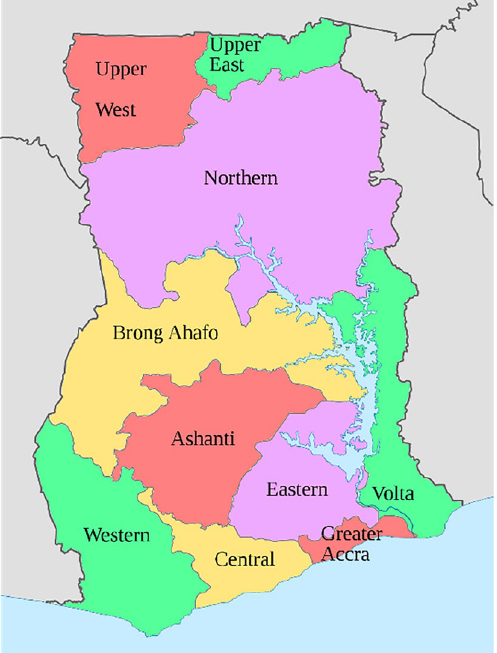
Fig. 1 Administrative regions of Ghana (Source: http:// wikim edia. org. File: